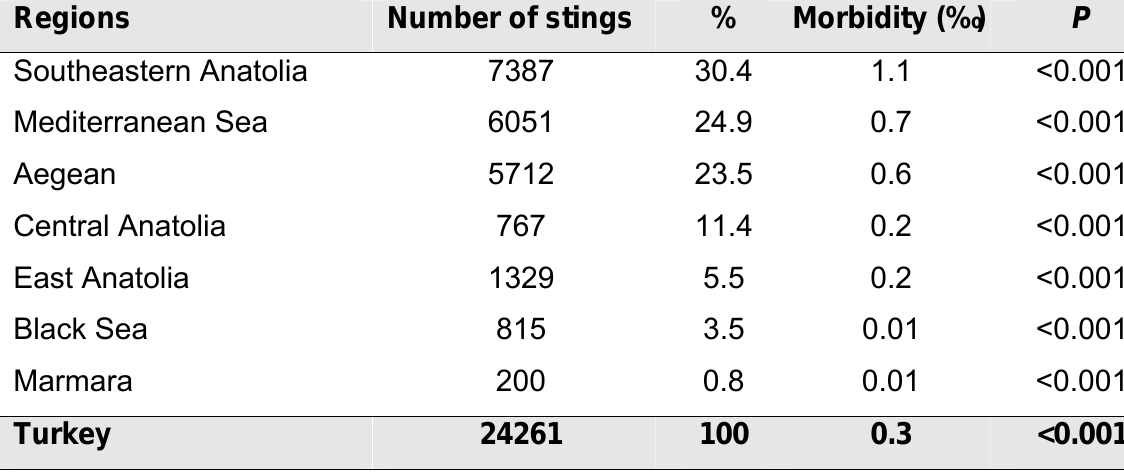
Figure 5. Seasonal distribution of the scorpion stings in Turkey. Except for the Marmara region, most stings were seen in the summer period. Table 1 . Morbidity ratios according to the regions of